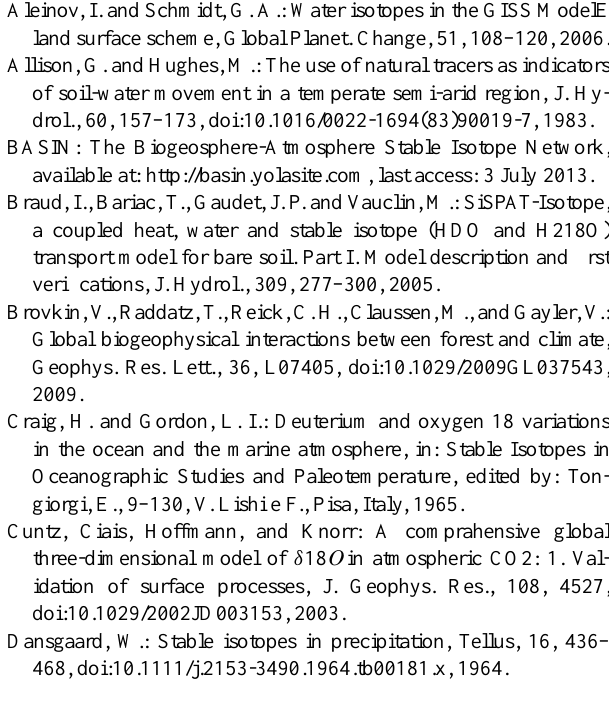
Fig. 14. Comparison of the kinetic fractionation factor for Fig.14. Comparisonofthekineticfractionationfactorfortemperaturebelow20 ◦ C:(a)comparisonofsimulatedand observed (cid:14) 18 O P , and (b) relationship between Deuterium excess in precipitation ( dex P ) and (cid:14)D P . temperature below 20 ◦ C: (a) comparison of simulated and ob- served δ 18 O P , and (b) relationship between deuterium excess in precipitation (dex P ) and δD P 39